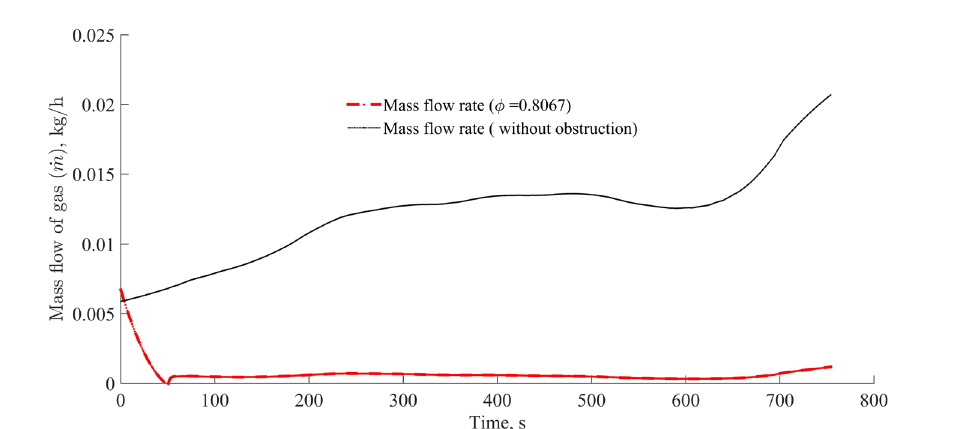
Fig. 11. Variation of mass flow rate of volatile gas (